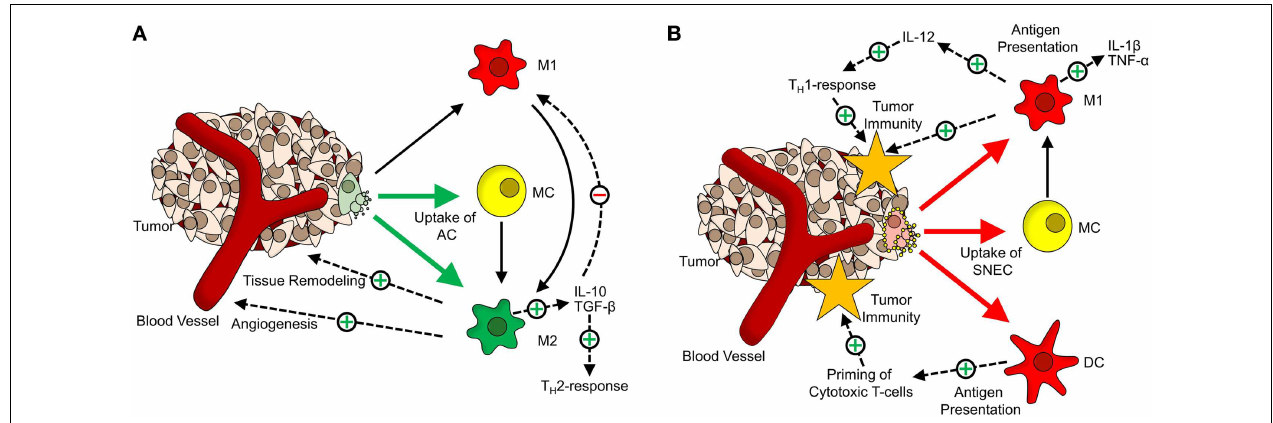
apoptotic cells are abrogated by Annexin-A5. Annexin-A5 (yellow circles on secondary necrotic cells) inhibits swift clearance of apoptotic cells, leading to progression of ACs into secondary necrosis. Secondary necrotic cells (SNEC) are mainly taken up by MCs, classically activated macrophages and dendritic cells (DC; red). Upon phagocytosis of SNEC, MCs get polarized toward the M1-phenotype. Phagocytosis of SNEC by DCs leads to antigen presentation and priming ofT cells. Classically activated macrophages secrete inflammatory cytokines (TNF- α , IL-1 β ) and induce TH1-responses via